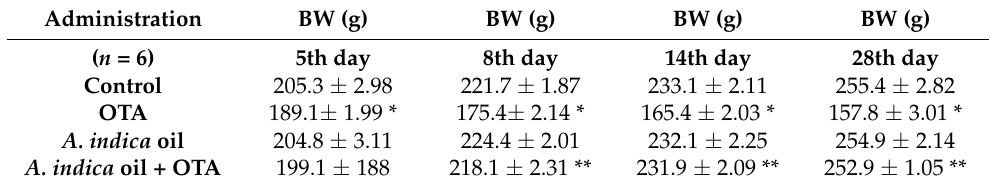
Table 1. Body weight ( BW ) was varied by group during the experiment; The mice from all four groups were measured on 5th, 8th, 14th and 28th days during the 28 days experiment; controls (standard diet, n = 6); OTA ( n = 6); A. indica oil ( n = 6); A. indica oil + OTA in combination ( n = 6). The quantitative data were expressed as the means ± SE. * p < 0.05 vs. control group; ** p < 0.05 vs. OTA treated